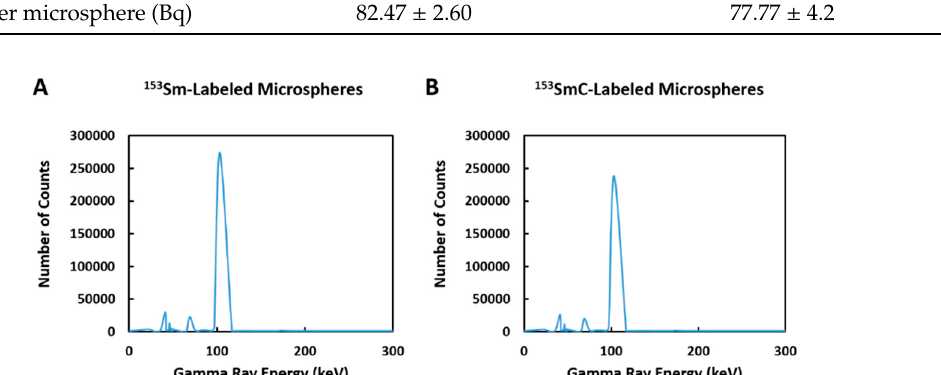
Figure 2. Gamma spectrum of 153 Sm-labeled microspheres ( A ) and 153 SmC-labeled microspheres ( B ) at 24 h post neutron activation.